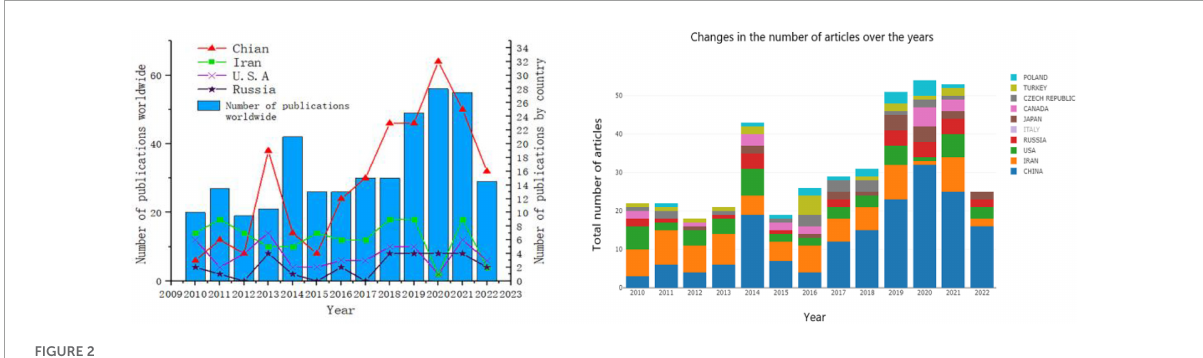
FIGURE2 Analysis of global document issuance from 2010 to